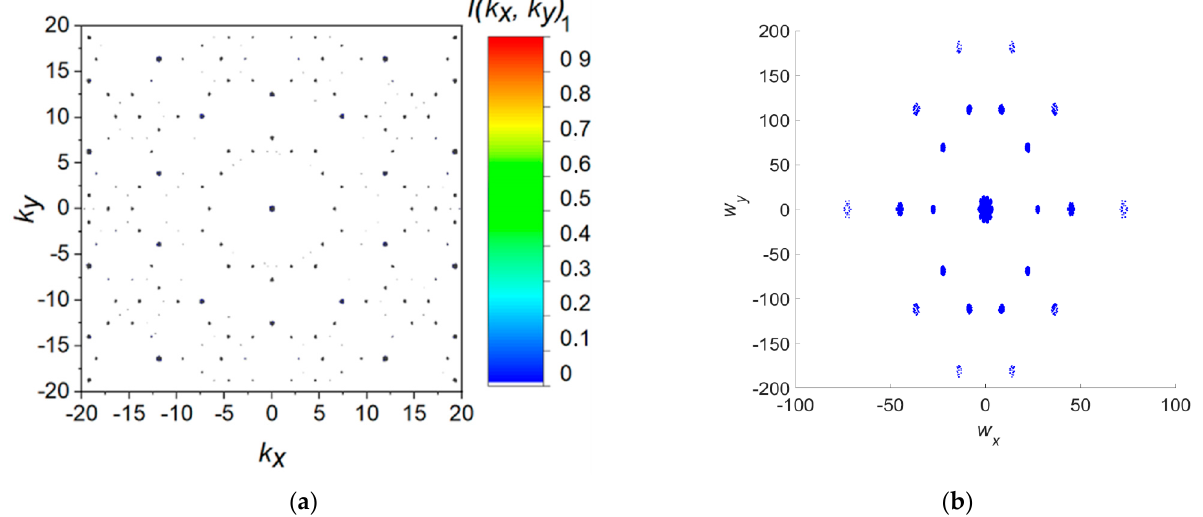
Figure 5. ( a ) Diffraction pattern of the Penrose tiling with monoatomic vertex decoration (all reflec- tions with n x – m y indices in a range − 12 . . . 12, 2300 atoms). ( b ) Reduced diffraction pattern of the Penrose